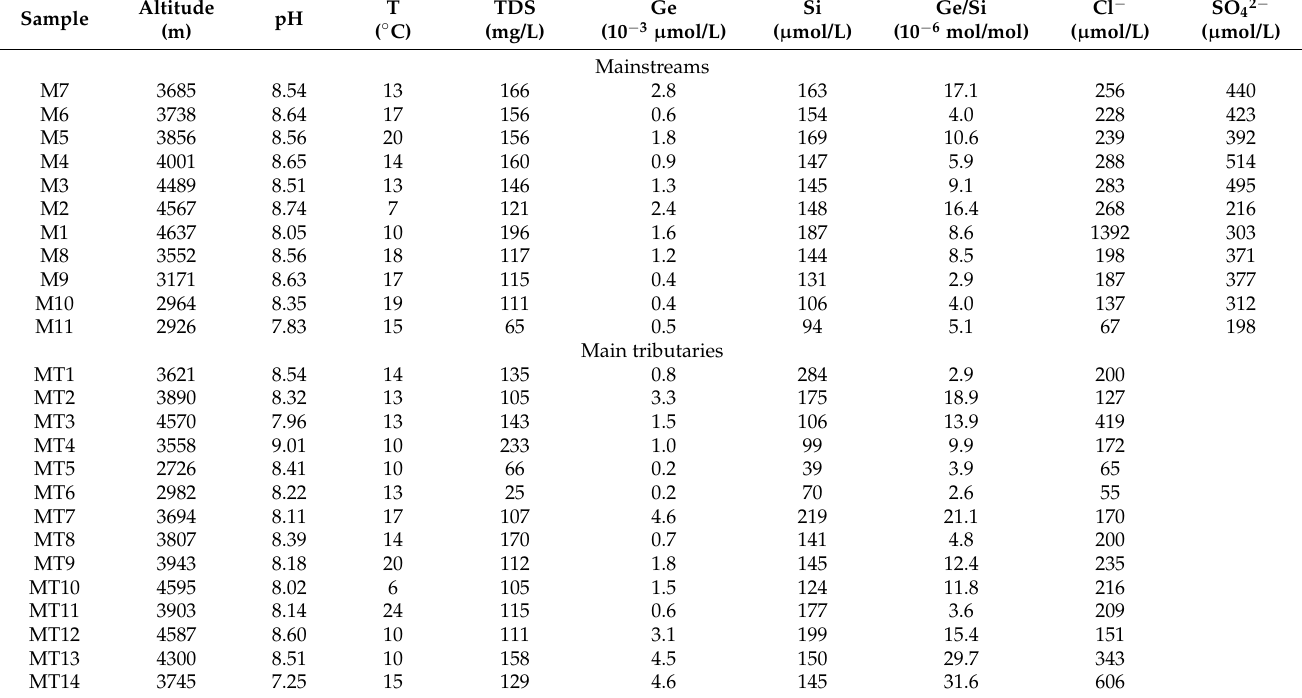
Table 1. Chemical compositions of river and hydrothermal water in the Yarlung